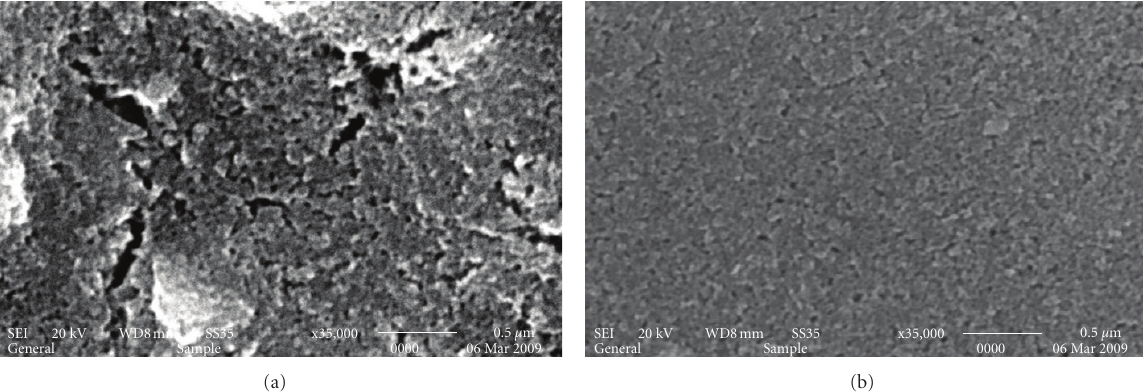
Figure 3: Surface structures of nanocrystalline-TiO 2 layer made using the TiO 2 -MG paste (a) and the TiO 2 -BM paste (b). Magnification is × 35,000. Each scale bar is 500 nm.